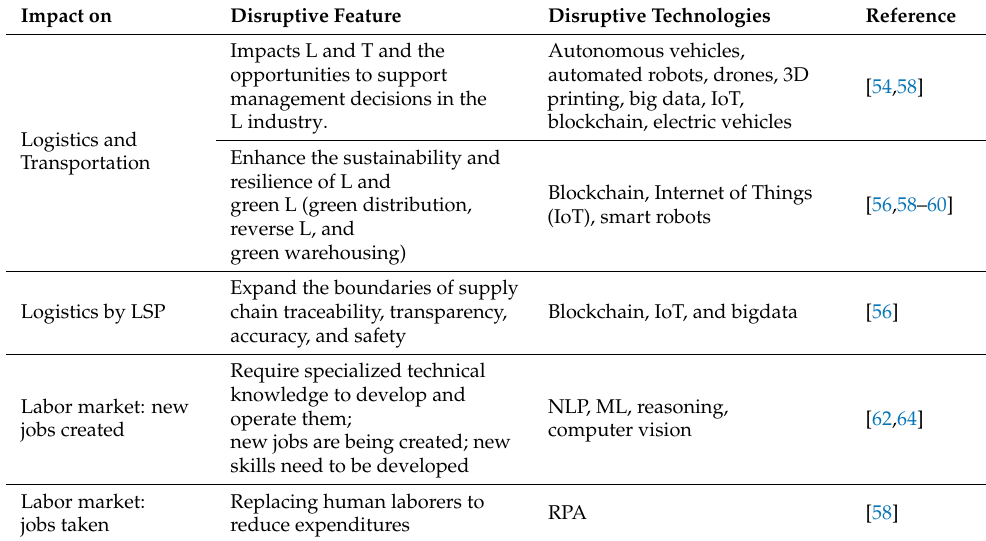
Table 7. The impact of disruptive technologies on L, T, and the labor market.